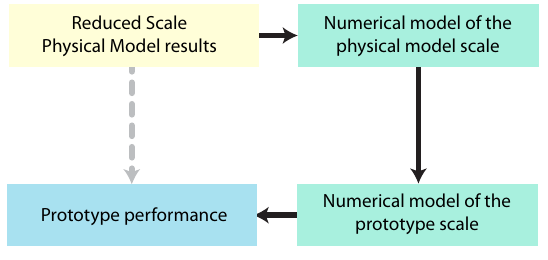
Figure 13: Outline of the methodology to predict prototype perfor- mance free of scale